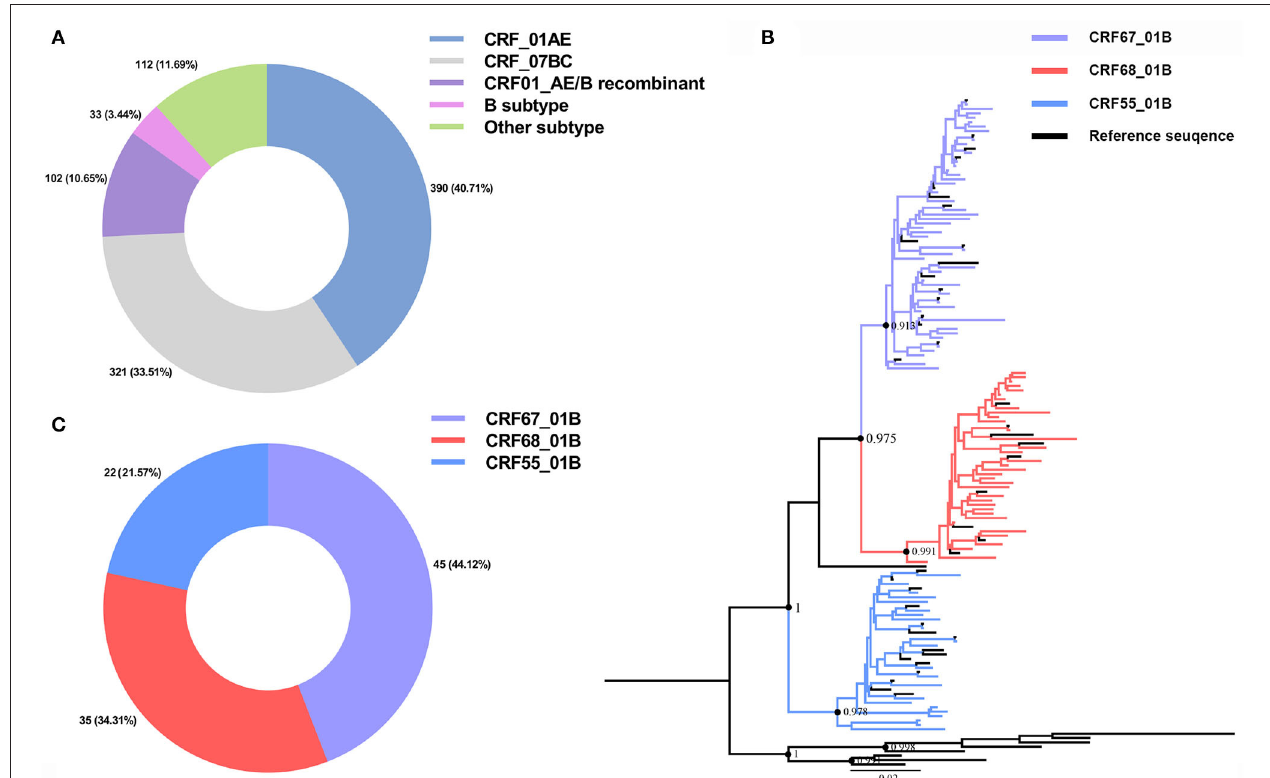
FIGURE 1 | Human immunodeficiency virus 1 (HIV-1) sub-typing based on the 958 partial Pol region sequences from newly diagnosed patients in Nanjing during 2015–2019 and reference sequences. (A) The HIV-1 subtypes distribution in Nanjing during 2015–2019. (B) The phylogenetic tree analysis of 102 CRF01_AE/B recombinants sequences of Nanjing. The different colors represented different CRF01_AE/B recombinants sequences and reference sequences. (C) The distribution of three subtypes of CRF01_AE/B recombinants in Nanjing during 2015–2019.